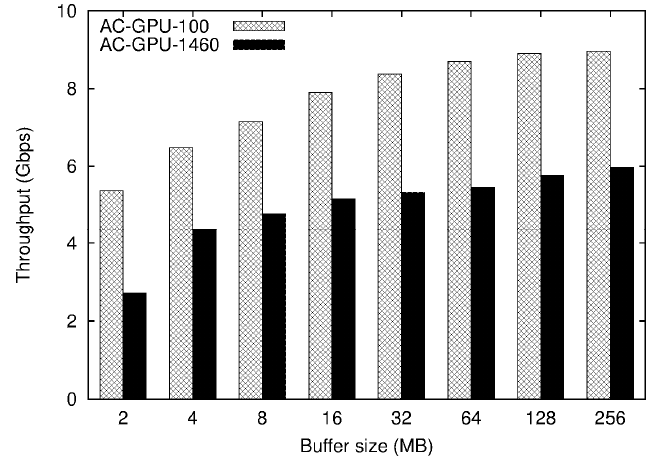
Figure 4. The data transfer rate between CPUs and GPUs with different full matching buffer sizes.